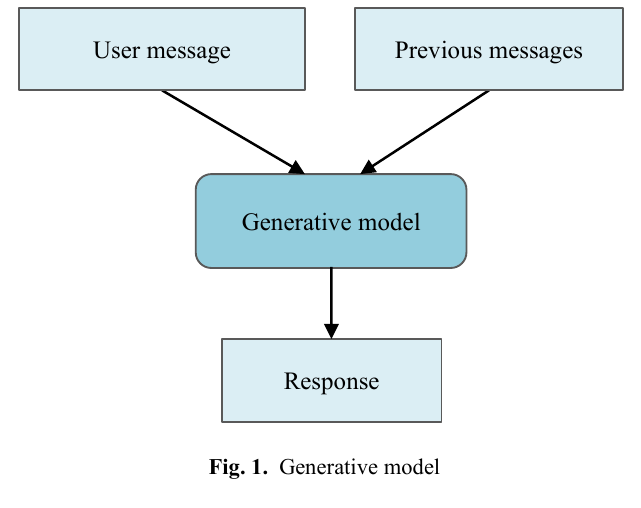
Fig. 1. Generative model